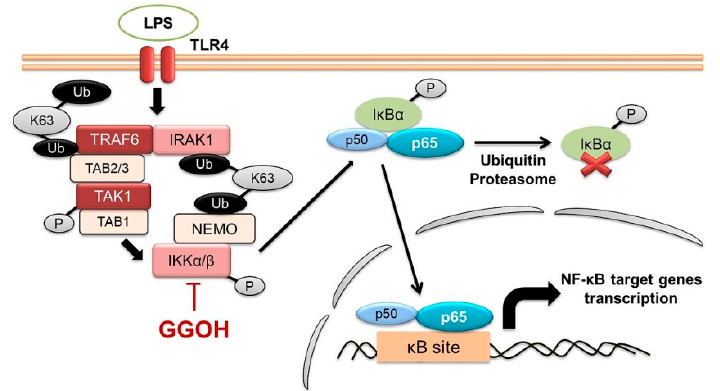
Figure 8. Possible molecular mechanism by which geranylgeraniol (GGOH) inhibited LPS-induced inflammation in MG6 cells. LPS induced NF- κ B activation via the subsequent phosphorylation of TAK1, IKK α / β , p65, and I κ B α , which triggered I κ B α degradation and p65 nuclear translocation. However, GGOH administration inhibited IKK α / β phosphorylation, which possibly modulate the downstream signaling cascade. Additionally, it also reduced TAK1 phosphorylation and attenuated upstream signaling events, especially IRAK1. Even though further investigation is necessary, there is a possibility that GGOH interferes with the interaction between IRAK1 and NEMO, thereby reducing IKK phosphorylation effectivity.